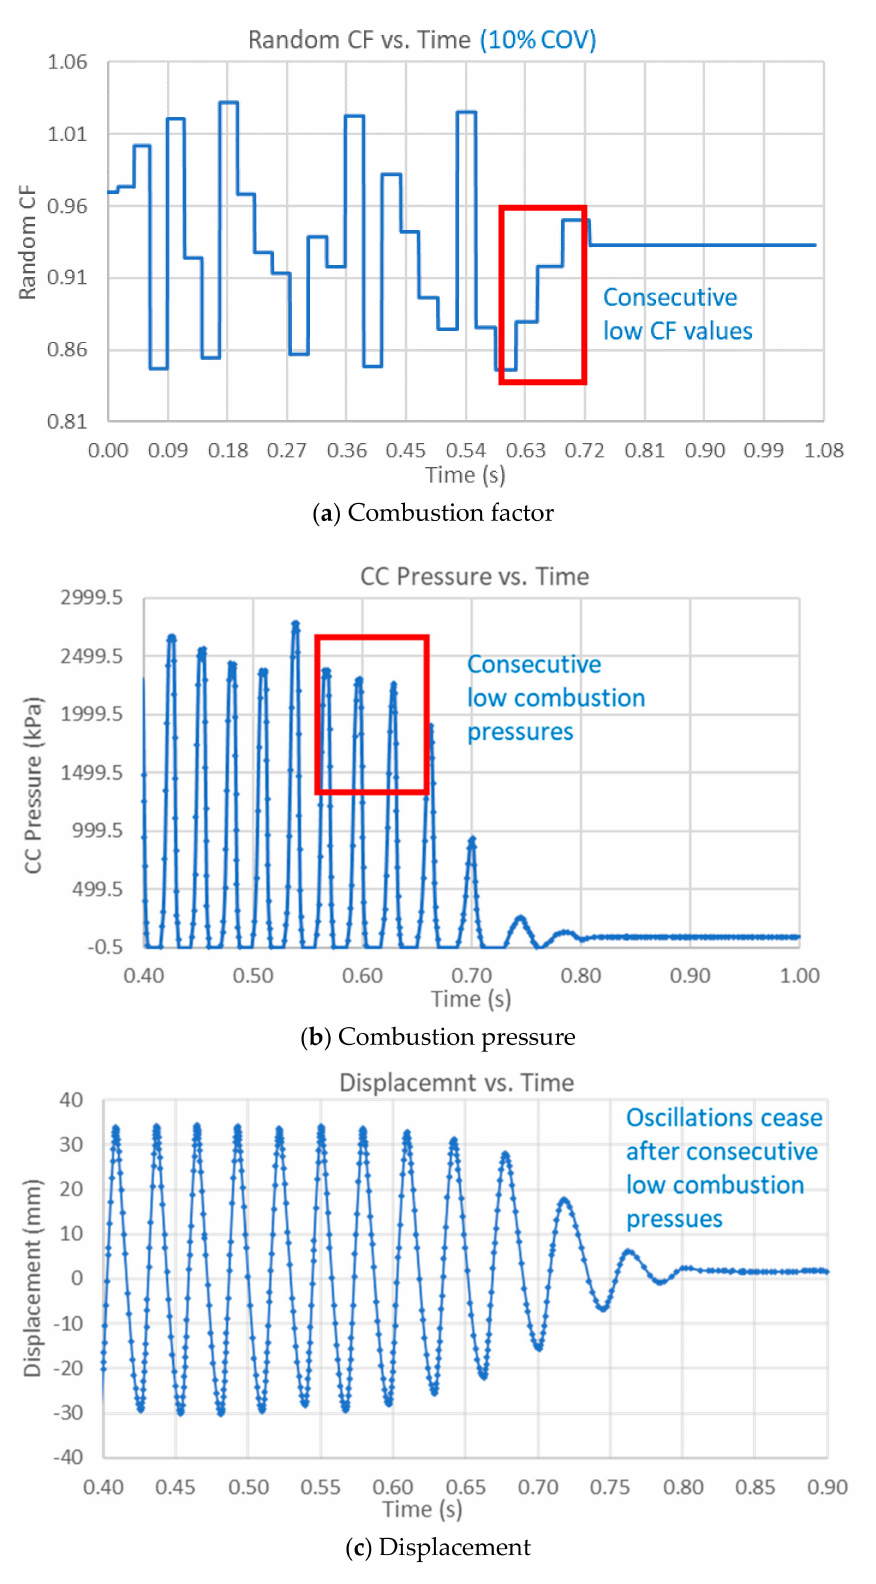
Figure 15. Results of time charts for simulation with cyclic combustion